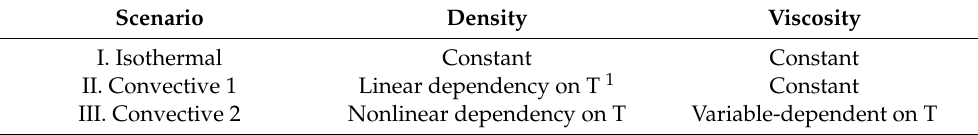
Table 1. Scenarios considered in the modeling analysis of flow and heat transport.